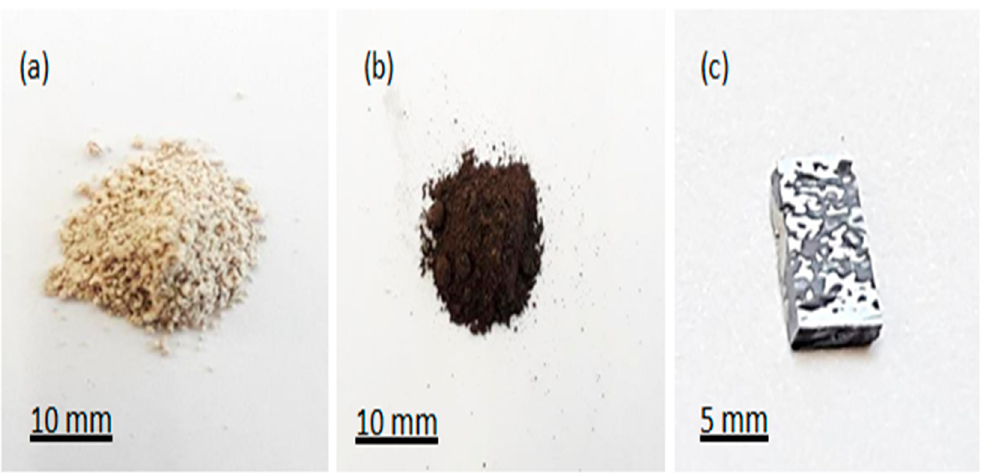
Figure 5. Photograph ( a ) reaction mixture before reduction, ( b ) remaining loose powder after reduction, and ( c ) silicon wafer surface after the reduction and etching.